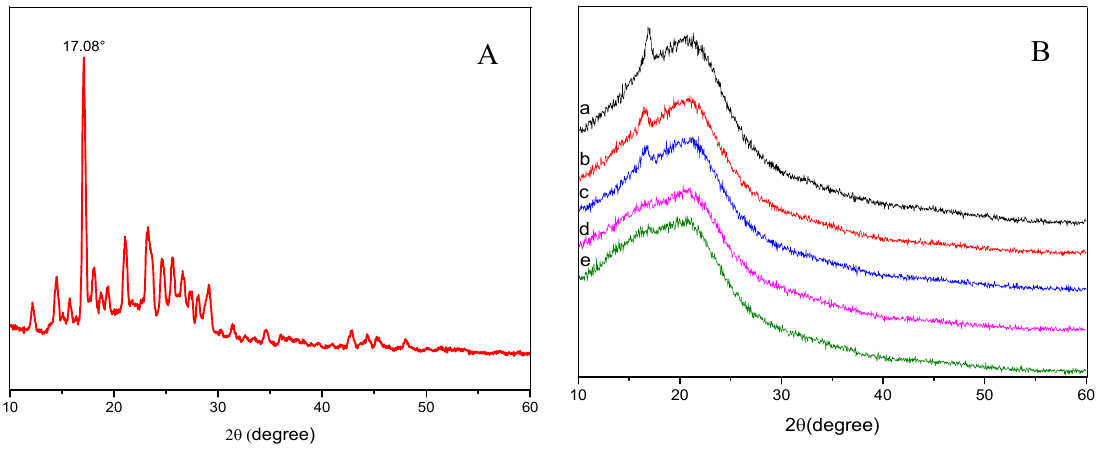
Figure 3. XRD spectra of Cur ( A ). XRD spectra of PLA/PEG/Cur CNFs with the different weight ratio